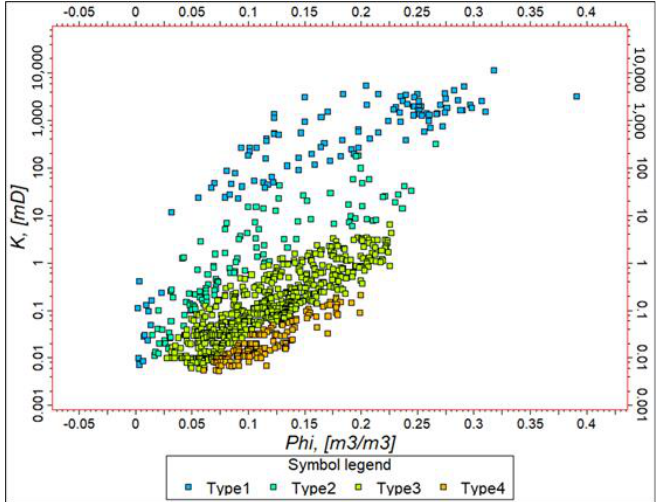
Figure 20. Porosity-permeability relations of the four rock types identified in H reservoir.